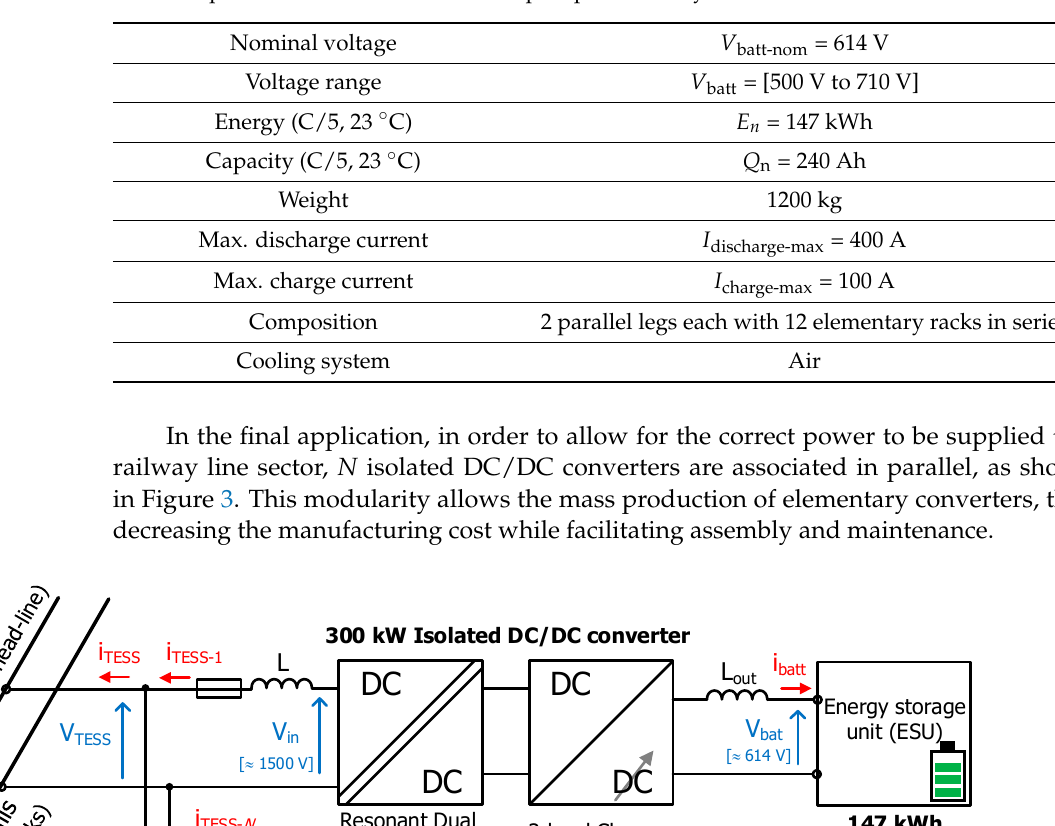
Table 3. Specifications of the lithium iron phosphate battery.